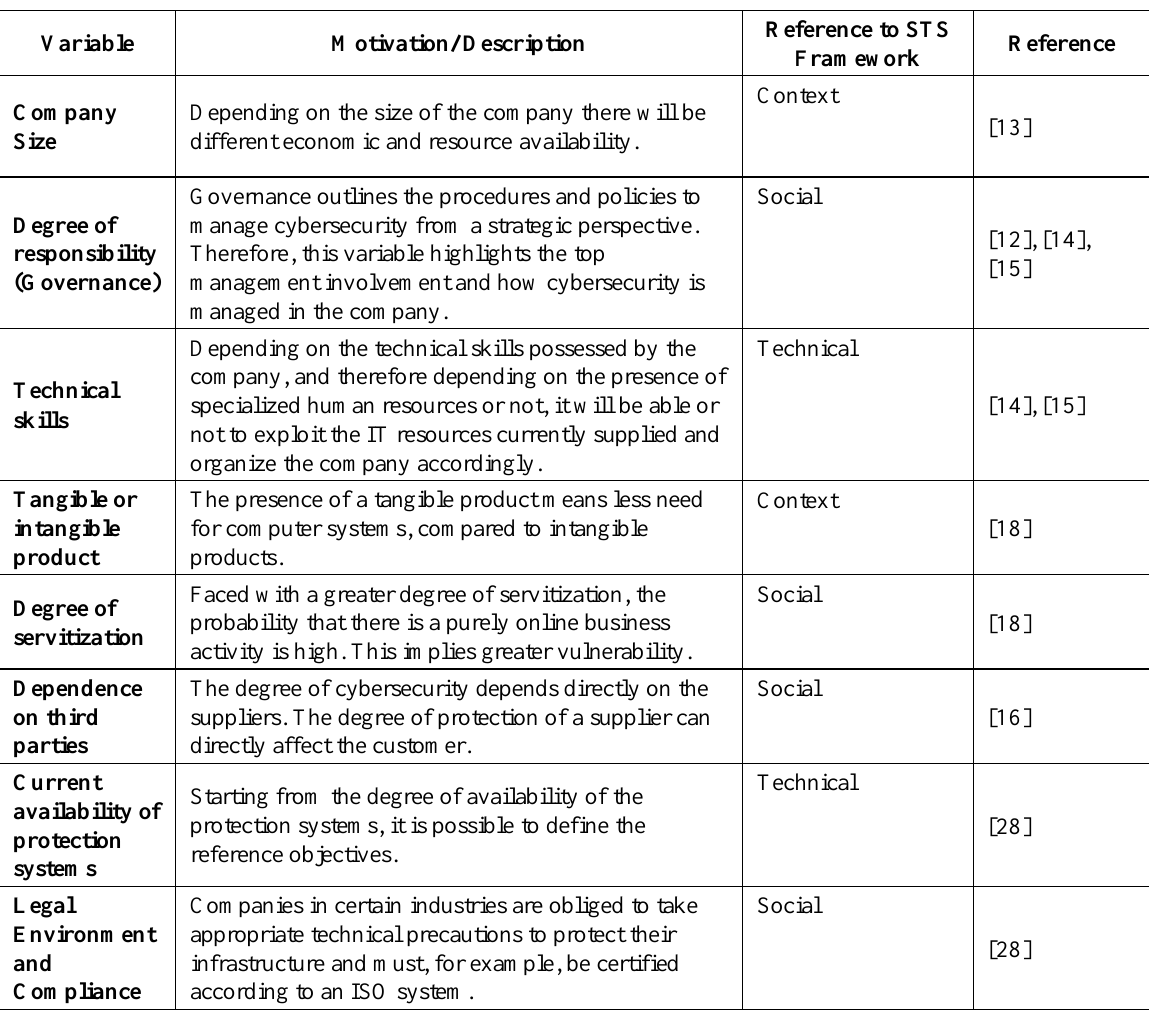
Table 2. The structure of the proposed CyberSecurity Readiness Model for SMEs